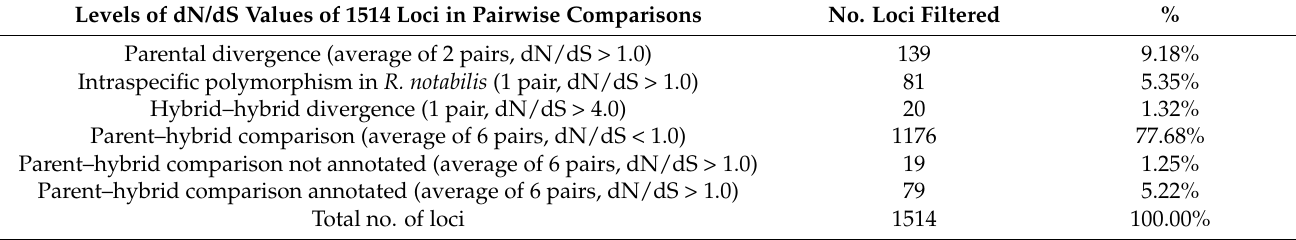
Table 2. Results of the filtering of loci according to dN/dS values for parental divergence and intraspe- cific and inter-hybrid divergence. The remaining loci were filtered for parent–hybrid dN/dS < 1.0 and finally for annotated loci.